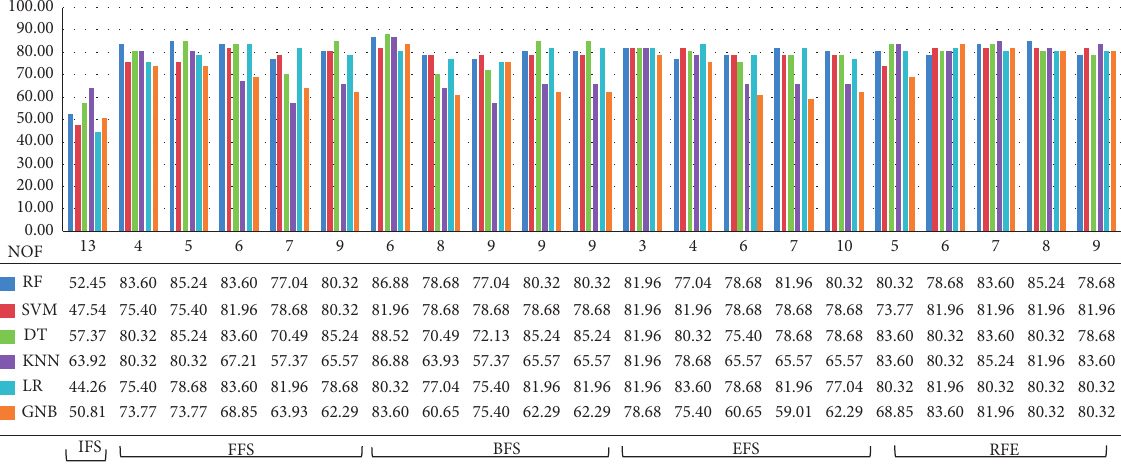
Figure 5: Classification accuracies of reduced feature subsets using wrapper-based methods with RF, SVM, DT, KNN, LR, and GNB (NOF: number of features, IFS: initial feature set, FFS: forward feature selection, BFS: backward feature selection, EFS: exhaustive feature selection, RFE: recursive feature selection).